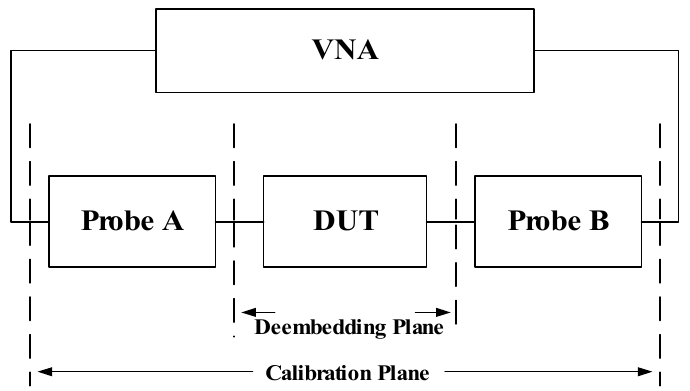
Figure 10. Schematic diagram of the measurement system frame.